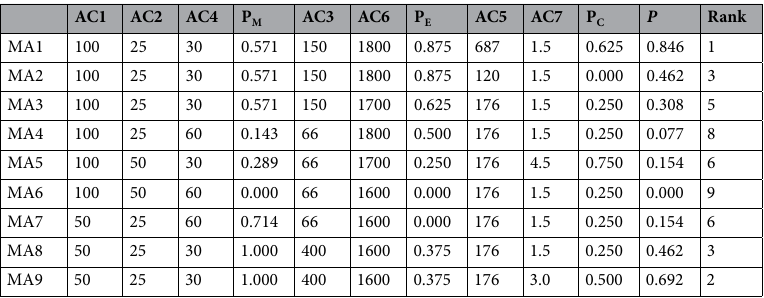
Table 10. Scoring alternatives in the marine sub-